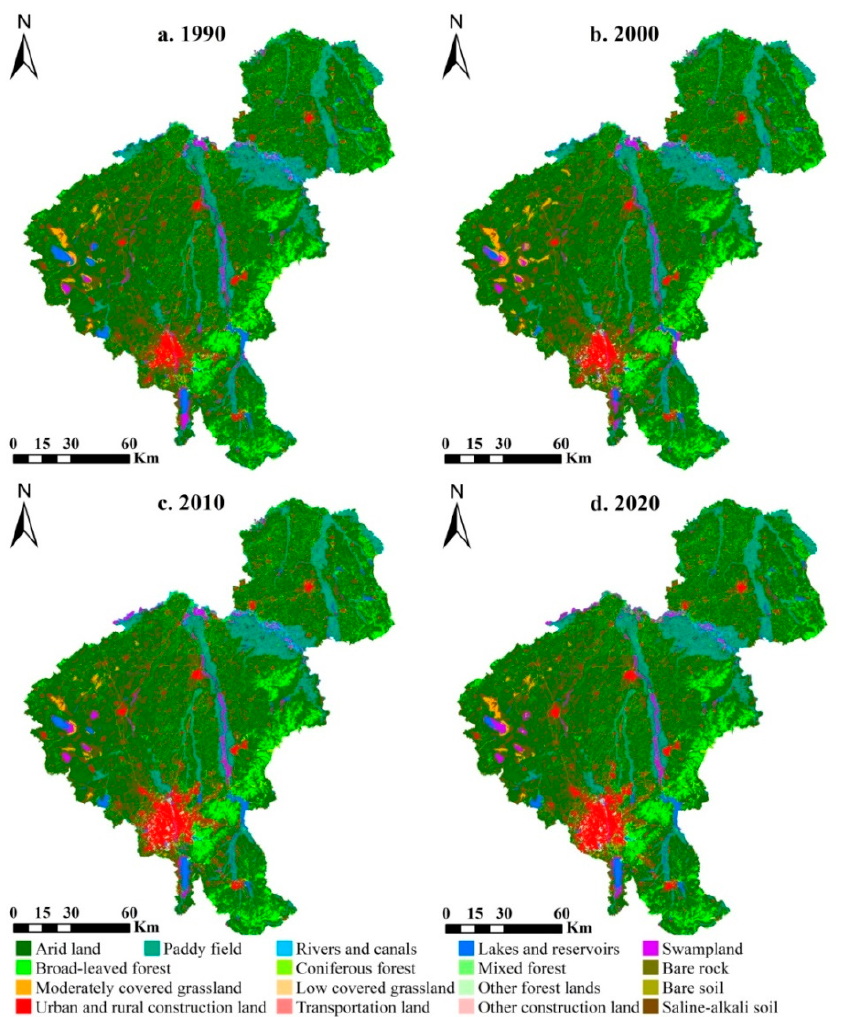
Figure 2. Map of the LULC patterns in Changchun City in 1990 ( a ), 2000 ( b ), 2010 ( c ), and 2020 ( d ), respectively.